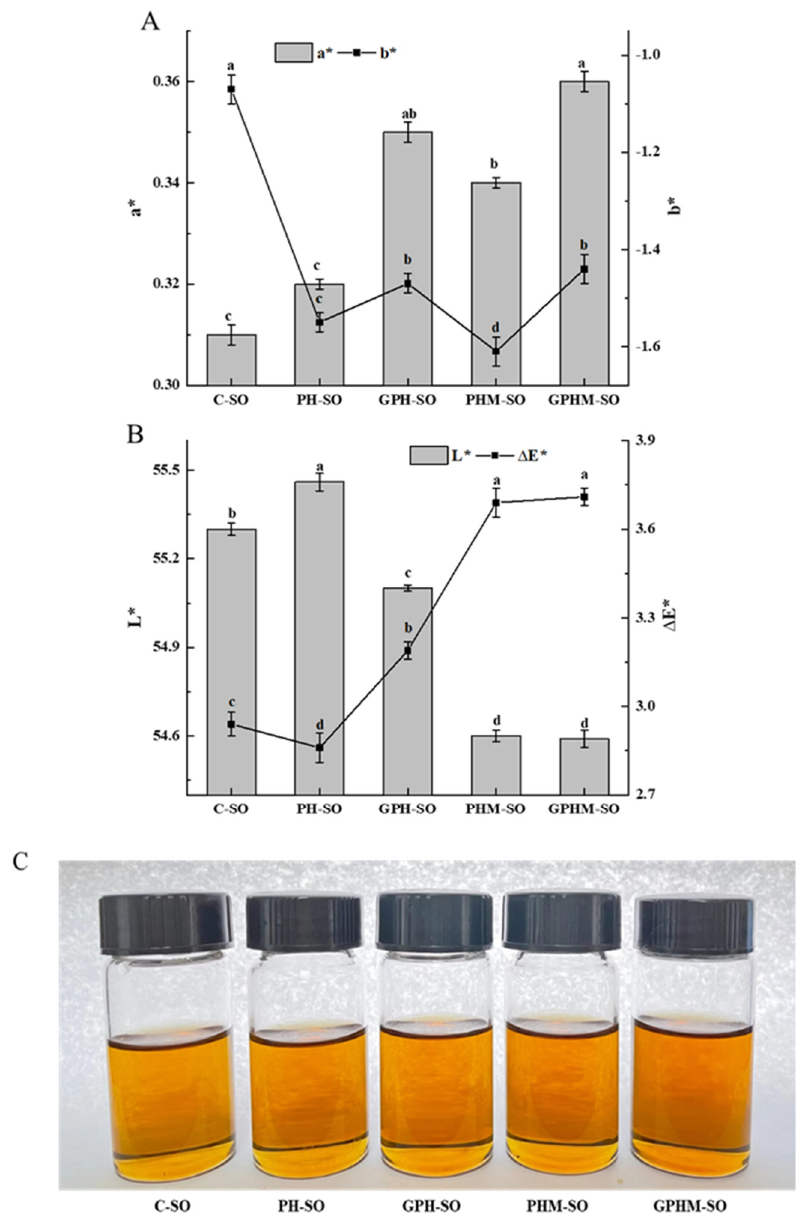
Figure 1. Color change in the oils with different treatments. ( A ) Redness or greenness (a*) and yellowness or blueness (b*) value of sesame oils, ( B ) brightness or luminosity (L*) and total color difference ( ∆ E*) of sesame oils, and ( C ) appearance of different processed sesame oils. Note: C-SO stands for the crude oil, PH-SO stands for the oil treated with hydrolysate without glucoamylase, GPH-SO stands for the oil treated with hydrolysate with glucoamylase, PHM-SO stands for the oil treated with MRPs of the hydrolysate without glucoamylase, and GPHM-SO stands for the oil treated with MRPs of the hydrolysate with glucoamylase. Values followed by different lowercase letters (a–e) mean statistically significant differences ( p < 0.05) among different kinds of oils.